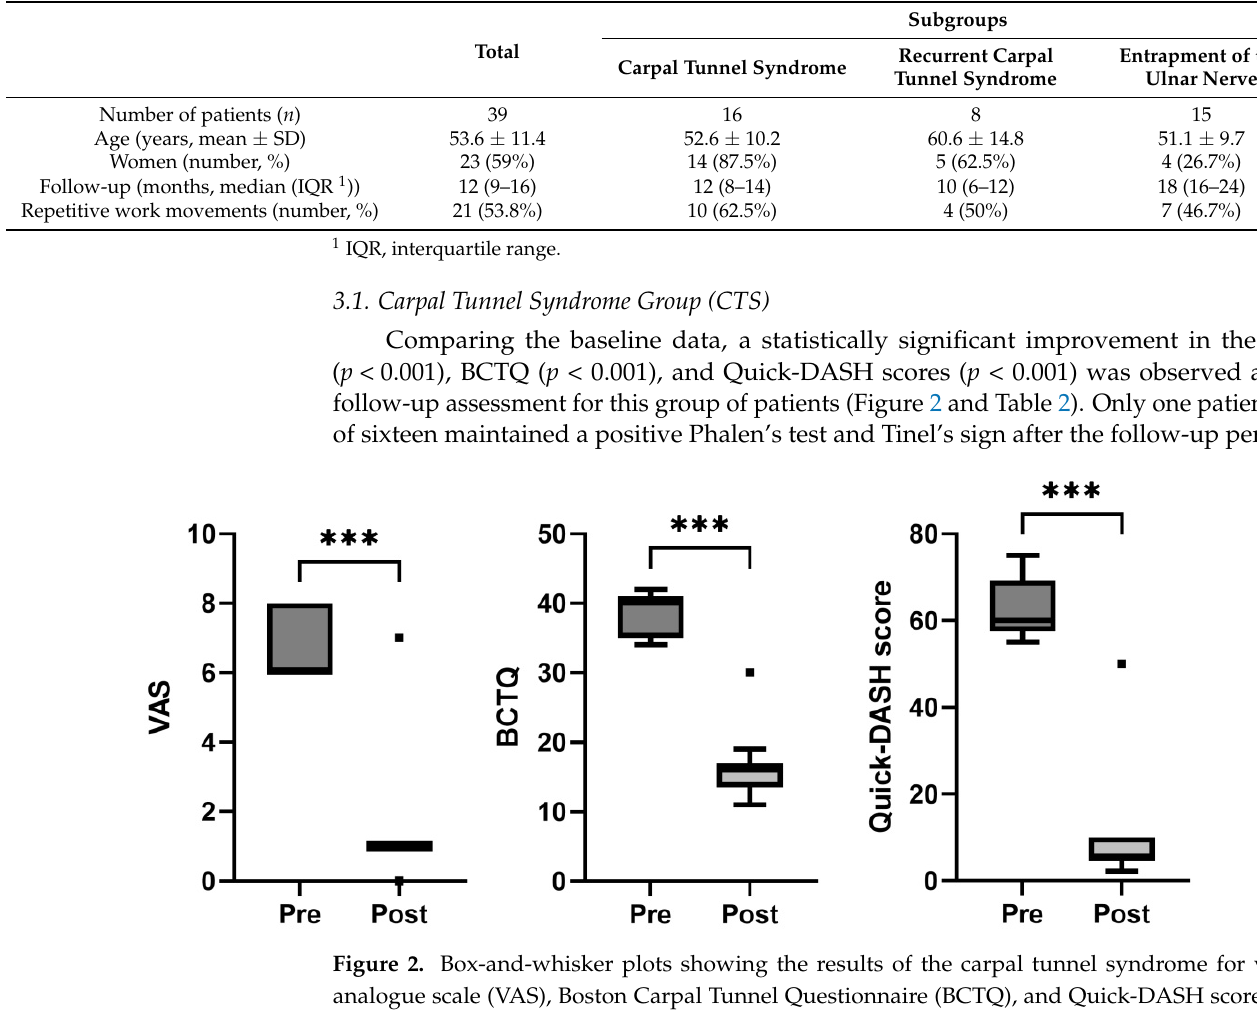
Table 1. Demographic characteristics of the patients.